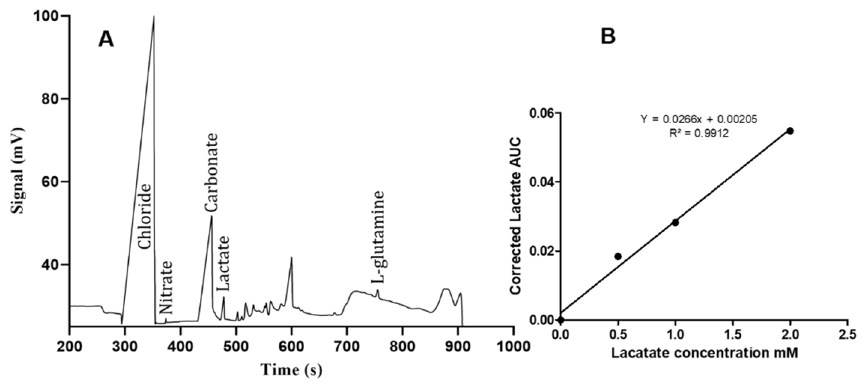
Figure 4. ( A ) Electropherogram of analyzed anions in prepared RPMI-1640 cell culture media. Conditions were as follow: 90 cm × 50 µm I.D. fused silica capillary coated with